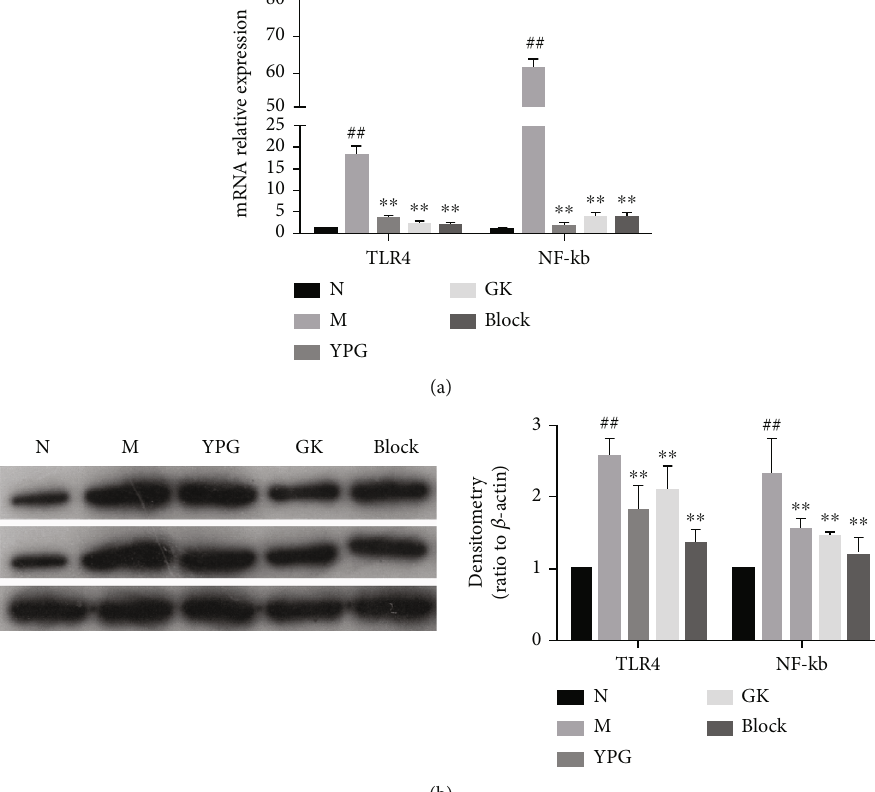
Figure 8: E ff ect of YPG on the expression of the pyroptosis factor in BA rats. (a) mRNA levels of TLR4 and NF- κ B were determined by real- time quantitative PCR. (b) The change in TLR4 and NF- κ B protein expression was observed by western blotting. Notes: ## P < 0 : 01 compared with the normal group; ∗∗ P < 0 : 01 compared with the model